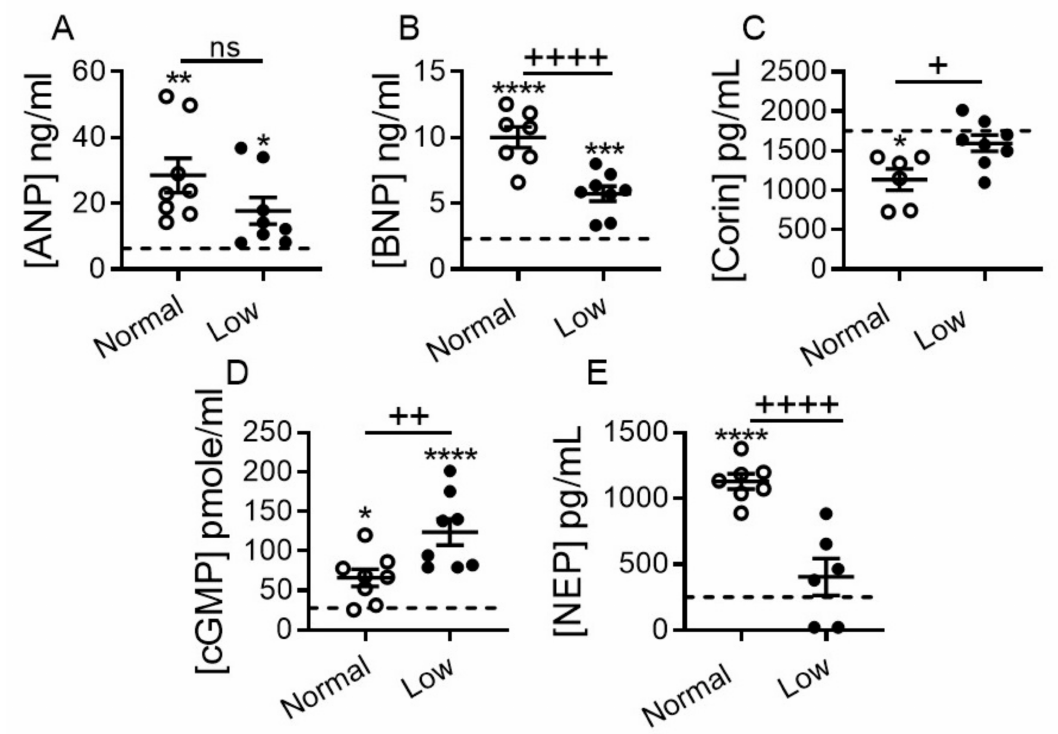
Figure 6. Impact of dietary sodium restriction on heart failure plasma biomarkers in mice with DCM. ( A ) Plasma levels of ANP, ( B ) BNP, ( C ) corin, ( D ) cGMP, and ( E ) neprilysin (NEP). All groups were 17 weeks of age. Number of DCM mice n = 6–8 per group. WT mice (dashed line, n = 7–8). Data are presented as mean ± SEM. **** p < 0.0001, *** p < 0.001, ** p < 0.01, * p < 0.05 (DCM vs. WT), and ++++ p < 0.0001, ++ p < 0.01, + p < 0.05 (DCM on NSD vs. DCM on LSD), ns = non-significant. Data were analyzed by one-way ANOVA with Newman–Keuls multiple comparison